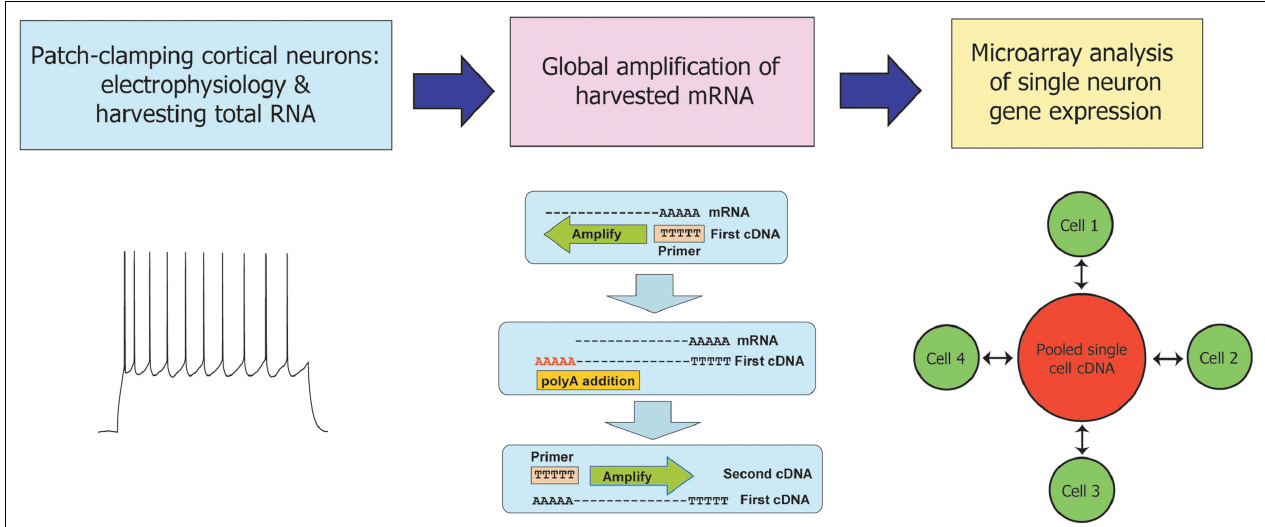
FIGURE 1 | Expression profi ling of single mouse cortical neurons following characterization of their electrical properties. Experimental design of the study reported here. Layer II/III neurons were patch-clamped and their fi ring properties analysed as described (Materials and Methods). The cytoplasmic contents of each cell were harvested by aspiration into the patch pipette and